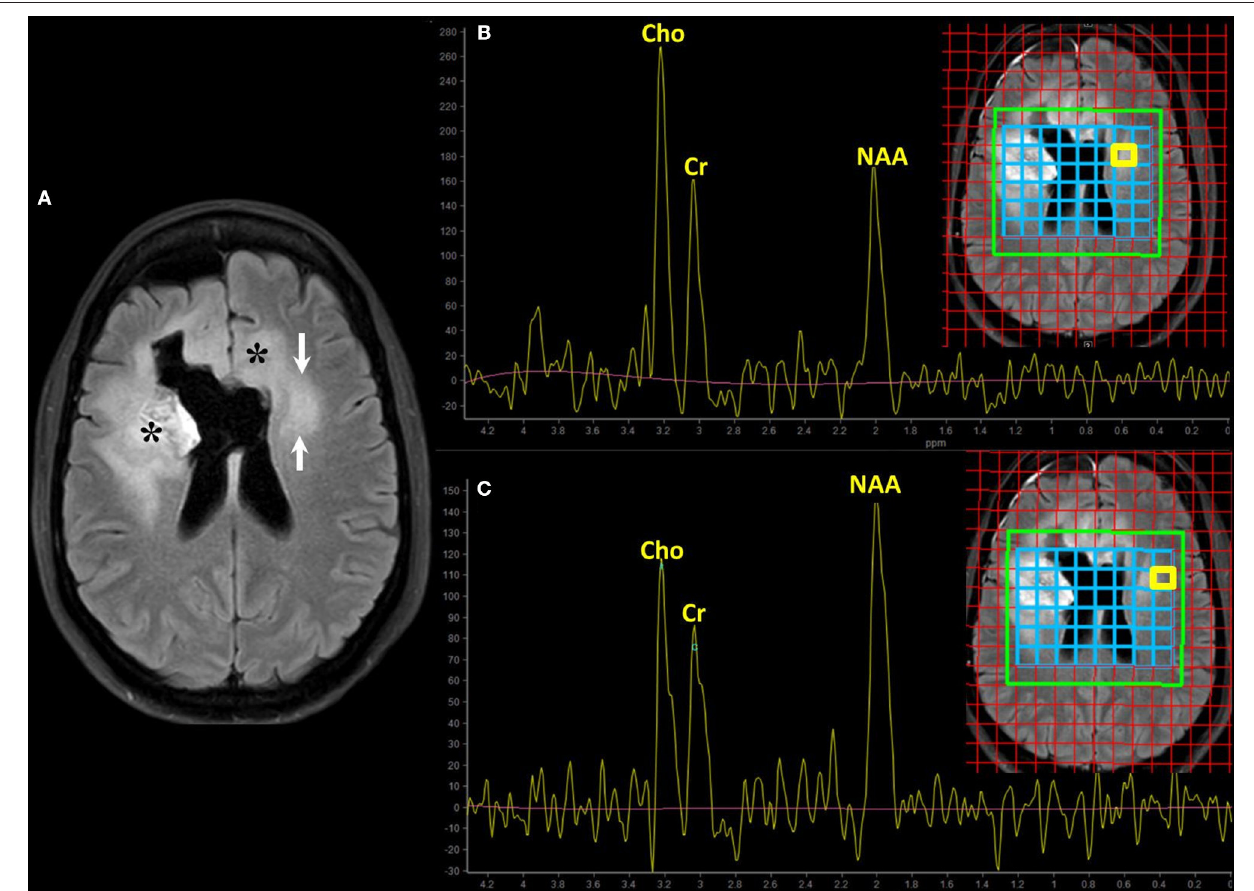
FIGURE 4 | Magnetic resonance spectroscopy (MRS) for the assessment of cell proliferation. Brain MRI of a old patient with recurrent GBM (NOS, MGMT status unknown) on bevacizumab treatment (same patient of Figure 2 , second row). Axial FLAIR (A) shows hyperintensity surrounding the surgical cavity on the right frontal lobe and in the contralateral periventricular white matter; asterisks (*) mark the enhancing areas seen on the previous scan. The clinical concern is to define whether the evolving area of FLAIR abnormality on the left side is vasogenic edema or tumor infiltration (arrows on A ). Multivoxel MRS using intermediate echo time (144ms) with interrogations on the region of interest (B) and the adjacent normal-appearing white matter (C) was performed. The spectrum corresponds to the area highlighted by the yellow box on the blue grid on the localizer images. The relative increase of choline (Cho) and the decrease in the N-Acetylaspartate (NAA) peak in the suspicious area compared to the normal-appearing one suggest high cell turnover rate and loss of neuronal integrity, respectively. These spectroscopic findings favor tumor infiltration over vasogenic edema.